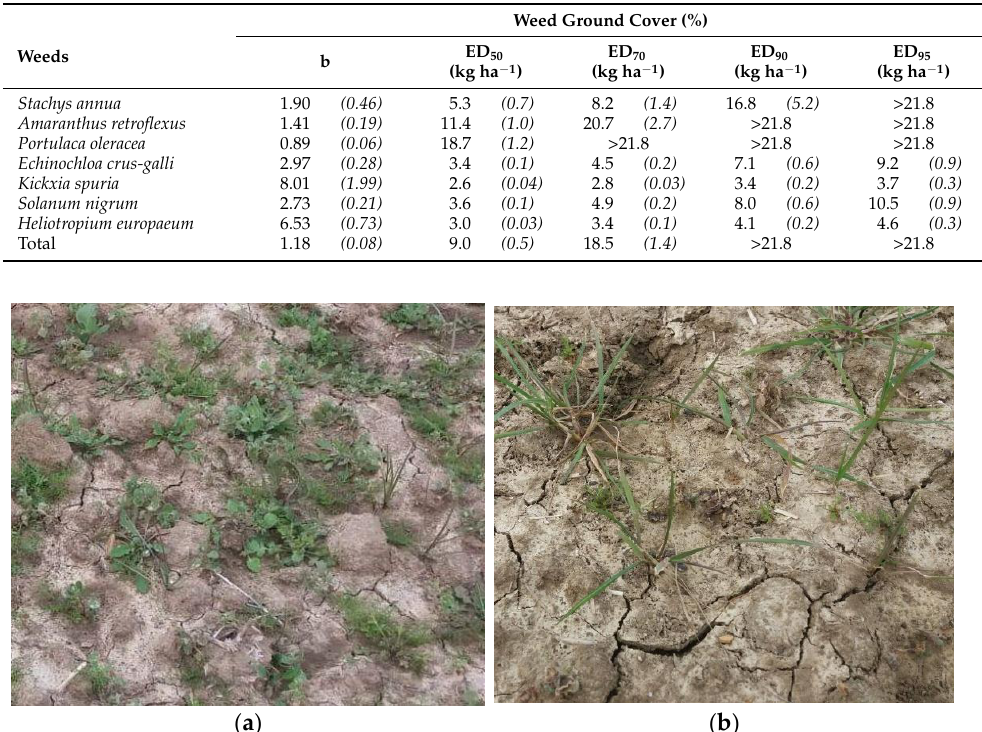
Table 3. Dose-response curves parameters (b, ED 50 , ED 70 , ED 90 , ED 95 ), based on weed ground cover, calculated from the fitted equations in Figure 2. Standard errors are in parentheses.